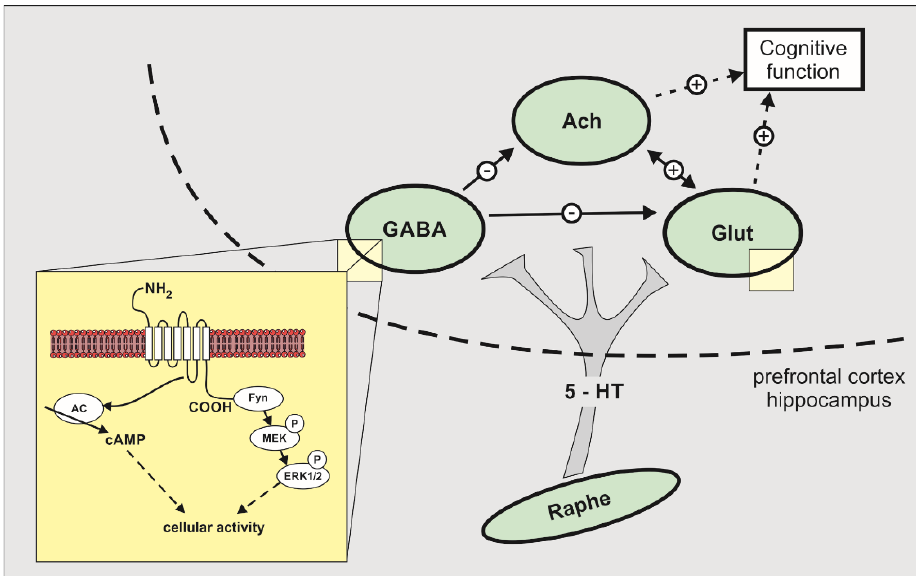
Figure 1. Neurochemical and biochemical mechanisms mediating 5-HT6 receptor functions. In addition to the activation of cAMP signalling pathways, 5-HT6 receptors activate the extracellular signal regulated kinase1/2 (ERK1/2) via Fyn-dependent pathway. The proposed neurochemical circuitry for 5-HT6 receptors to influence cognition involves modulation of cholinergic and/or glutamatergic activity through GABAergic interneurons. AC: adenylate cyclase; ACH: acetylcholine; Glut: glutamate. (+): stimulation; ( — ): inhibition. (adapted and modified from [11]).